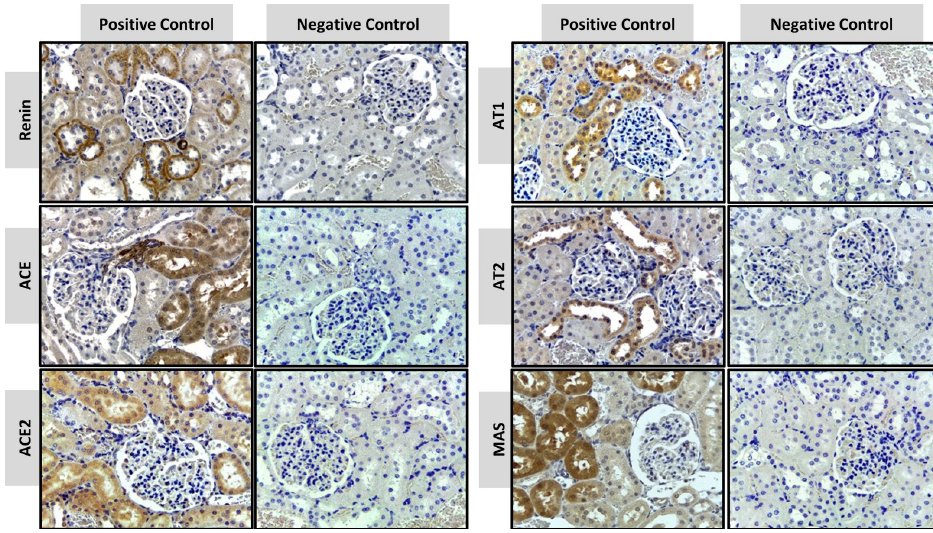
Fig 3. Positive and negative controls in immunohistochemical staining of RAS targets in the granular cortex of the kidney. Immunostains are shown as a brown color in positive controls of REN, ACE, ACE-2, AT1, AT2 and MAS. (x40 objective and scale bar = 50 μ